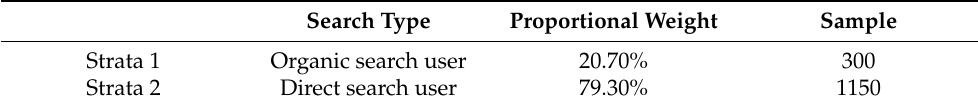
Table 2. Post-test: Time a customer spends watching the